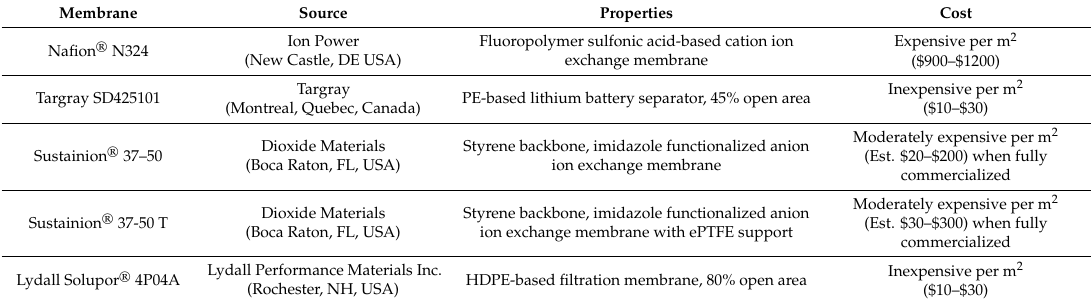
Table 1. Membrane / microporous separator materials selected for formic acid (FA) pervaporation testing.